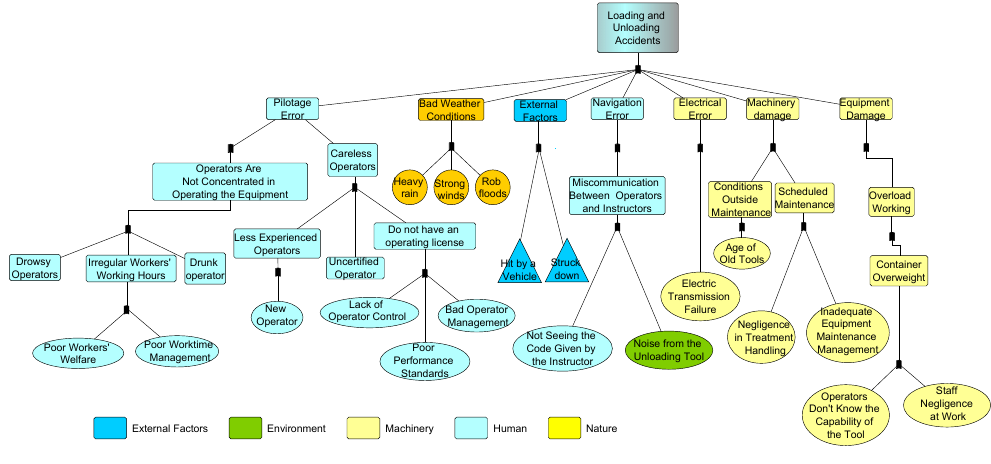
Figure 3. FTA of Loading and Unloading Accidents.